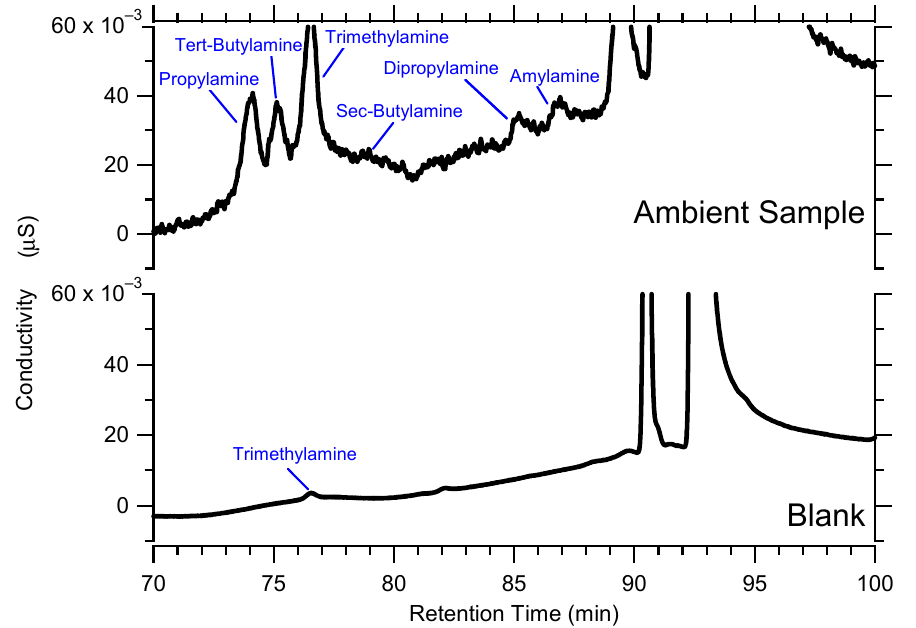
Figure 5. Chromatogram comparison of the same ambient filter sample shown in Figure 1 (top) and a blank (bottom) filter sample. The separation was performed on a Thermo Scientific Dionex IonPac CS-19 (4 × 250 mm) column using the separation method described in the main text. Note only data from 70 to 100 min, which includes the gradient and second isocratic step of the separation, are being shown to illustrate the low detection limit for the amines.